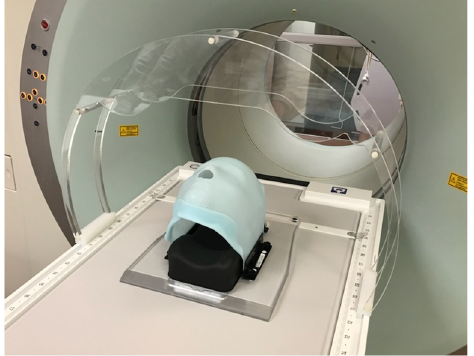
Figure 3. Acrylic replica of anterior coil bridge to test for patient clearance during simulation.